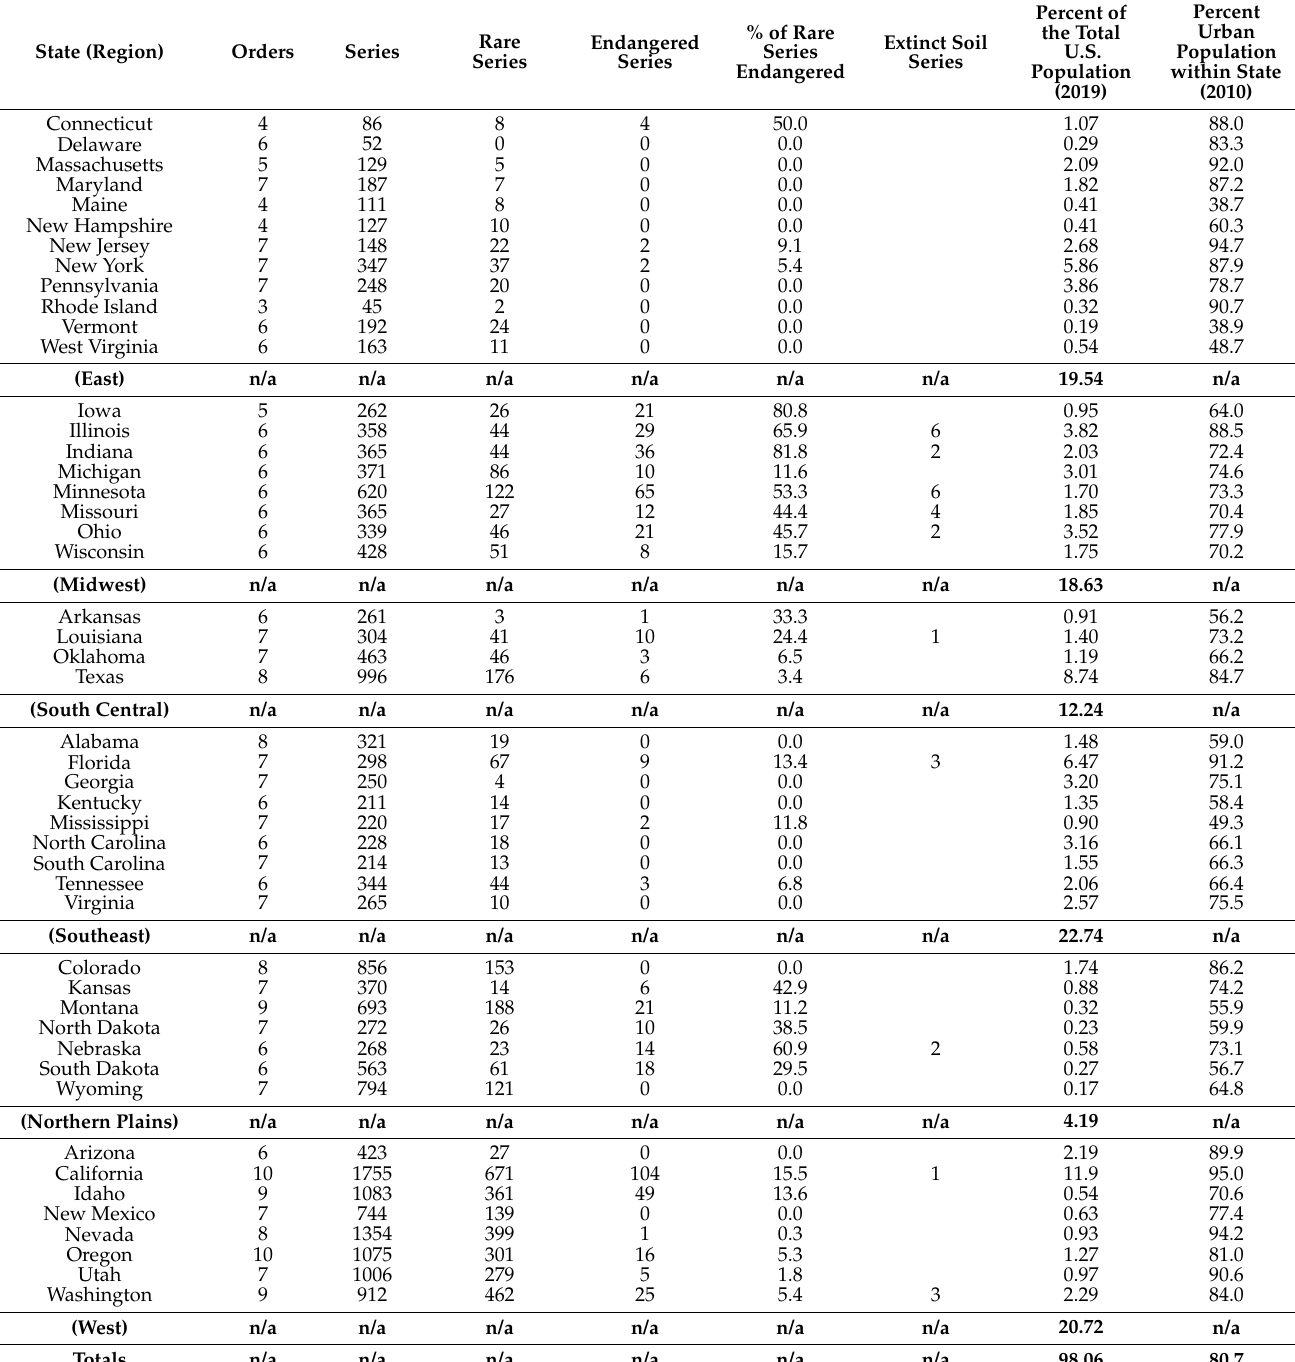
Table 13. Pedodiversity and selected population statistics in the contiguous United States (U.S.) (adapted from Amundson et al., 2003 [2], and Wikipedia